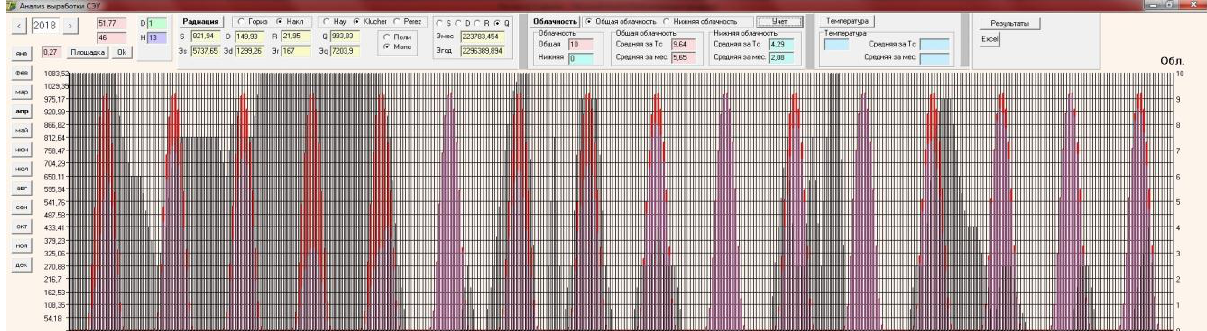
Fig. 4. The effect of cloudiness on the arrival of global solar radiation, April 1-16, 2018, Saratov. The global radiation is shown in purple, gray color indicates the total cloud cover in points from 1 to 10, red color shows the proportion of radiation lost due to the